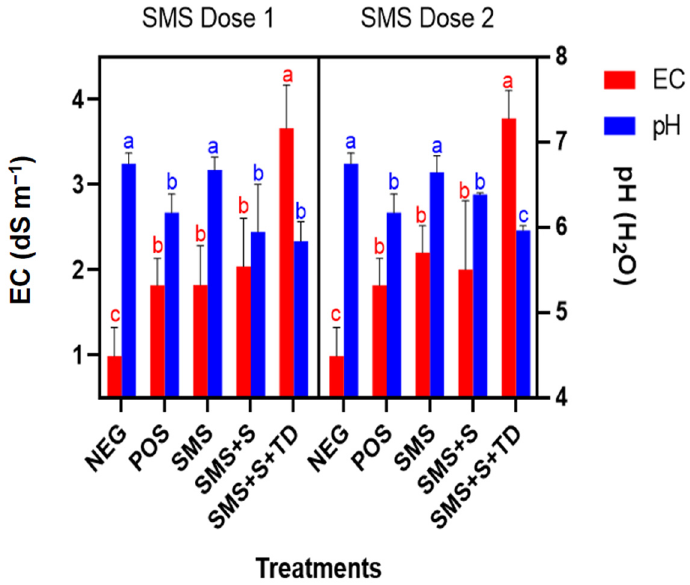
Figure 4. Electrical conductivity (EC) and pH. Lowercase letters between columns in the same dose differ according to the Tukey test ( p < 0.05).